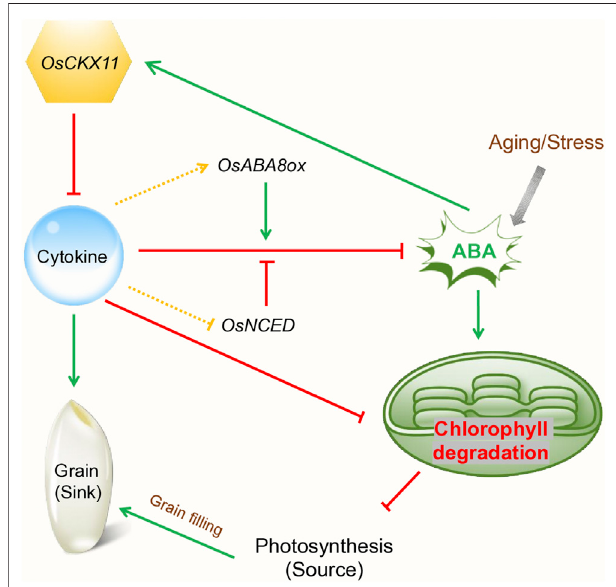
FIGURE 3 | Schematic presentation showing the role of OsCKX11 in cytokinin-mediated leaf senescence and grain number in rice (Modi fi ed from Zhang et al.,